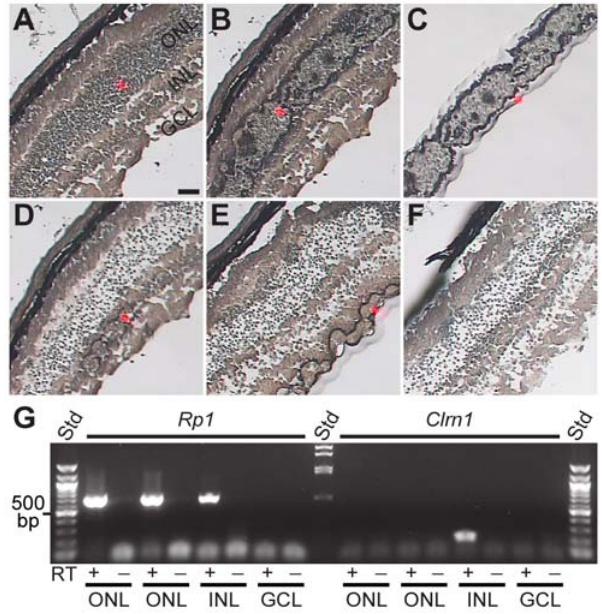
Figure 5. Laser capture microdissection of WT mouse retina. (A–F) Images of a section of WT C57BL/6J retina taken during the laser capture process. (A) Retina before laser capture. (B) The ONL is being captured on the cap. (C) The ONL after capture, on the surface of the microfuge tube cap just prior to total RNA extraction. (D) The ONL has been removed, and the INL is being laser-captured. (E) The ONL and INL have both been removed (though some cells remain), and the GCL (ganglion cell layer) is being laser captured. (F) Retina remaining after cell layers have been laser captured and collected on microfuge tube caps. (G) RT–PCR was used to amplify Rp1 (a photoreceptor specific transcript) and Clrn1 in each sample. Rp1 was detected in both ONL samples as well as the INL sample due to carry-over of a few photoreceptors, but was not detected in the GCL. Note that Clrn1 transcripts were only detected in the INL. Scale bar = 50 m m. ONL=outer nuclear layer, INL=inner nuclear layer, GCL=ganglion cell layer, and RPE=retinal pigmented epithelium. Clrn1 KO retina (Figure 7). Eighteen month old littermate animals (WT and KO ( 2 / 2 )) from early heterozygous matings were used. Antibodies used were: anti-Calbindin (horizontal and amacrine cells; Figure 7A–7D), anti-PKCa (rod bipolar cells; Figure 7E–7H), Rhodamine-PNA (cone photoreceptor sheaths; Figure 7I and 7J), anti-synaptophysin (OPL and IPL synaptic structures; Figure 7K and 7L), anti-GFAP and anti-vimentin (glial cells; Figure 7M–7P), and a chicken anti-CLRN1 antibody (Clarin160; Figure 7Q and 7R. See below, and Figure S4 and Figure S5). No differences between WT and Clrn1 KO ( 2 / 2 ) animals were found using these antibodies. Due to low levels of retinal CLRN1 expression, the anti-CLRN1 antibody labeling (Figure 7Q and 7R) represents non-specific signal in both WT and Clrn1 KO retinas. Labeling (Figure 7S and 7T). It is important to note that when an EGFP- CLRN1 fusion protein is overexpressed in 293 cells (see below, and Figure S4), specific labeling is readily observed using two different anti-CLRN1 antibodies, including the Clarin160 anti- body immunoreactivity shown here (Figure 7Q and 7R).